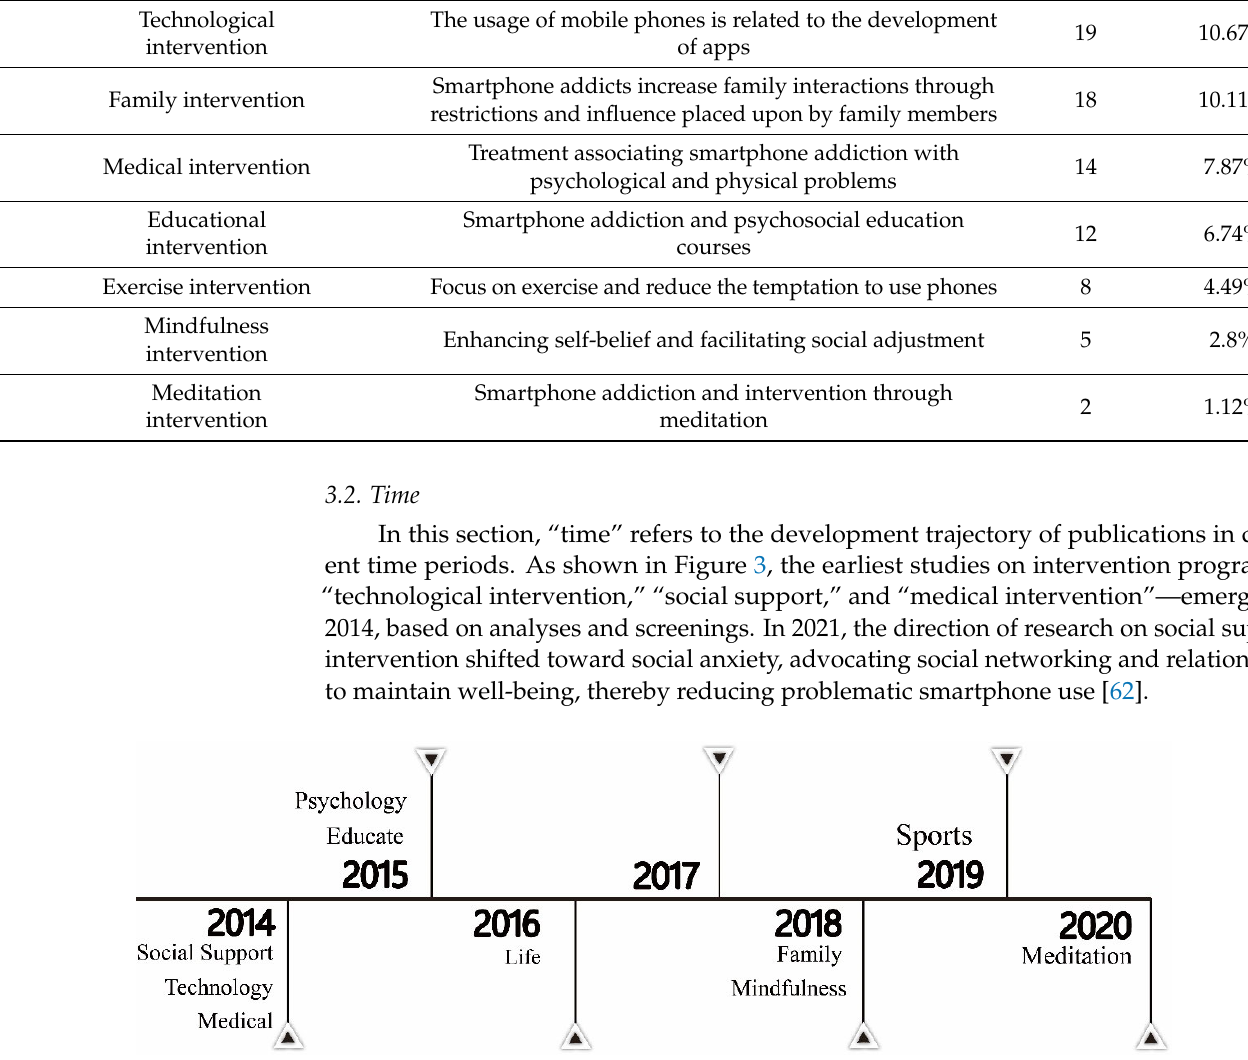
Figure 4. Countries/regions engaged in academic research. 3.4. Composition In this section, “composition” refers to understanding the structure of professional knowledge in a certain domain through exploring research topics and the types of rela ‐ tionships. Figure 5 illustrates the citation structure relationships among studies and indi ‐ cates that the research of intervention programs for smartphone addiction is recognized by many academic journals and that they are interconnected in this field. Computers in Human Behavior has the highest number of citations. Similarly, the visualization shows that this journal has the strongest connections and mutual influence with other journals.